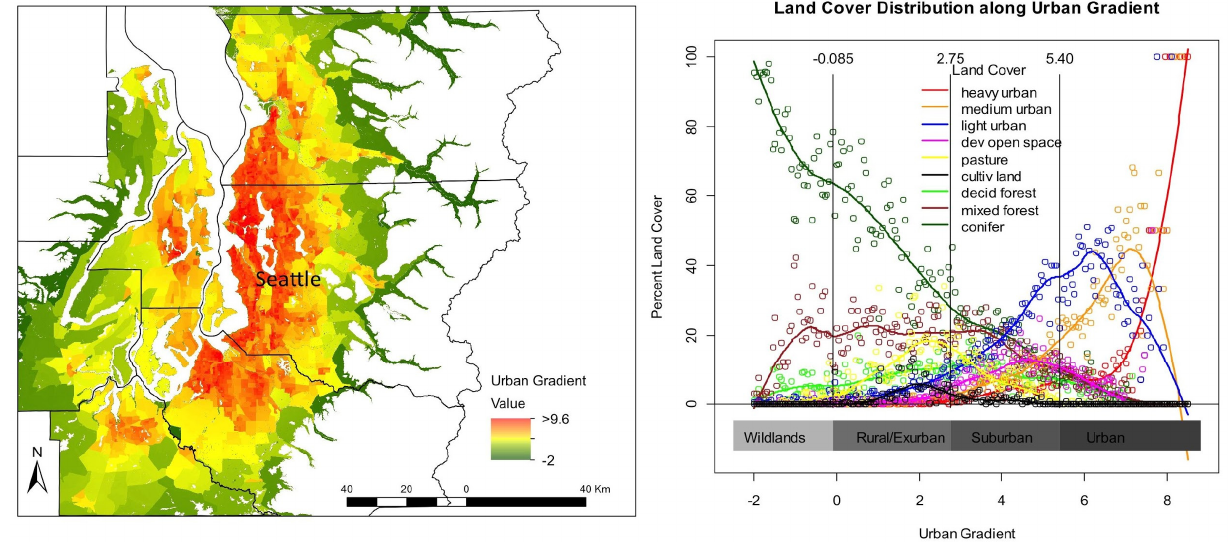
Figure 3. Map of the urban gradient with land cover distribution. Gradient index ranges from 9.6 (most urban) to − 2 (wildlands). Source of map and graph: Spirandelli, 2014